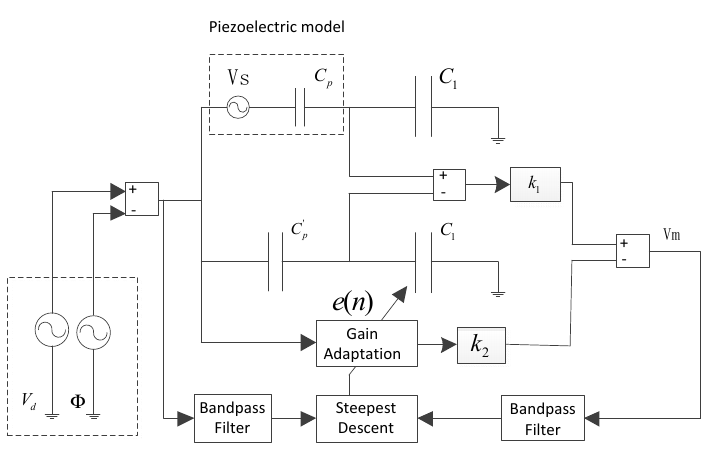
Figure 4. Schematic of the adaptive strategy for capacitance mismatching.